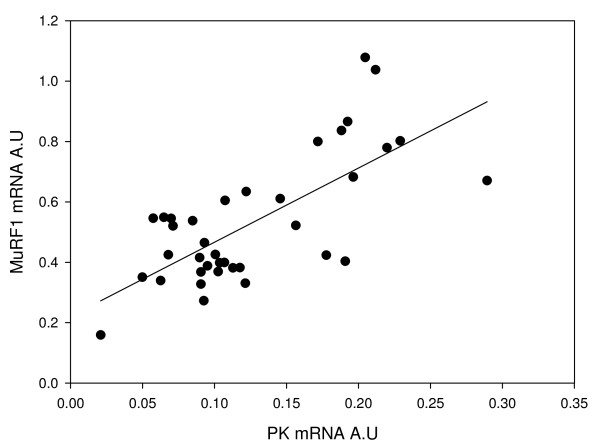
Correlation between MuRF1 and PKM mRNA (r2 = 0.50, p < 0.0001, n = 32).